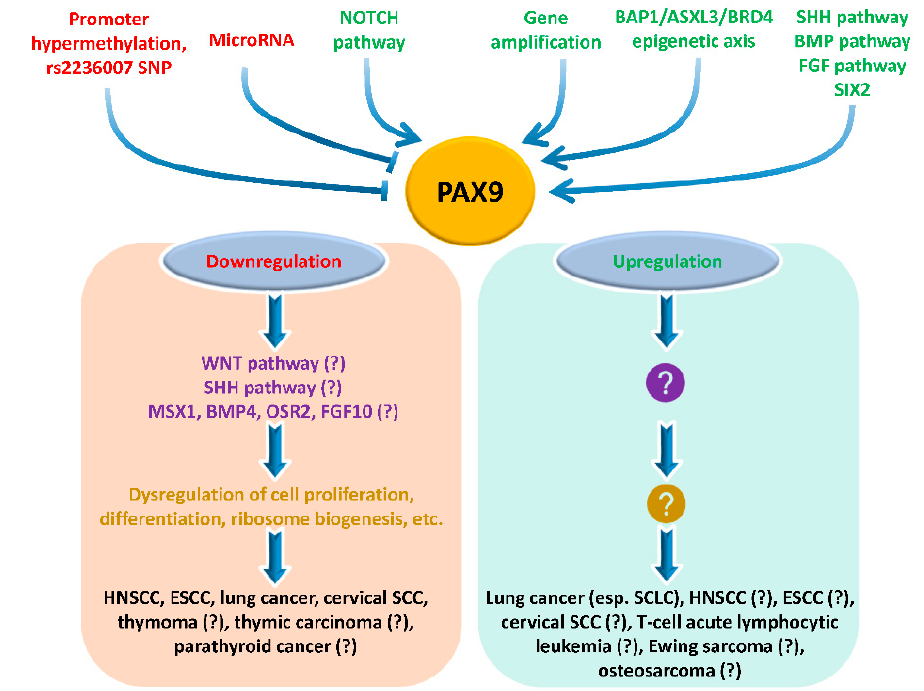
Figure 6. The role of PAX9 in cancer development. PAX9 expression is regulated by multiple upstream regulators. Aberrant expression of PAX9 impacts downstream genes and pathways and cellular phenotypes. However, its functions in cancer development depend on the cellular and tissue context, and its mechanistic roles in specific pathways, cellular phenotypes, and human cancer are largely unknown (question marks). ← , activation; Ⱶ ,